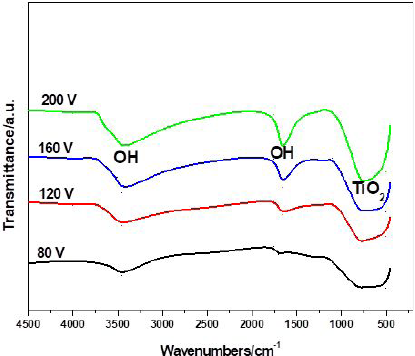
Figure 3. FTIR of the MAO coating prepared at various voltages.